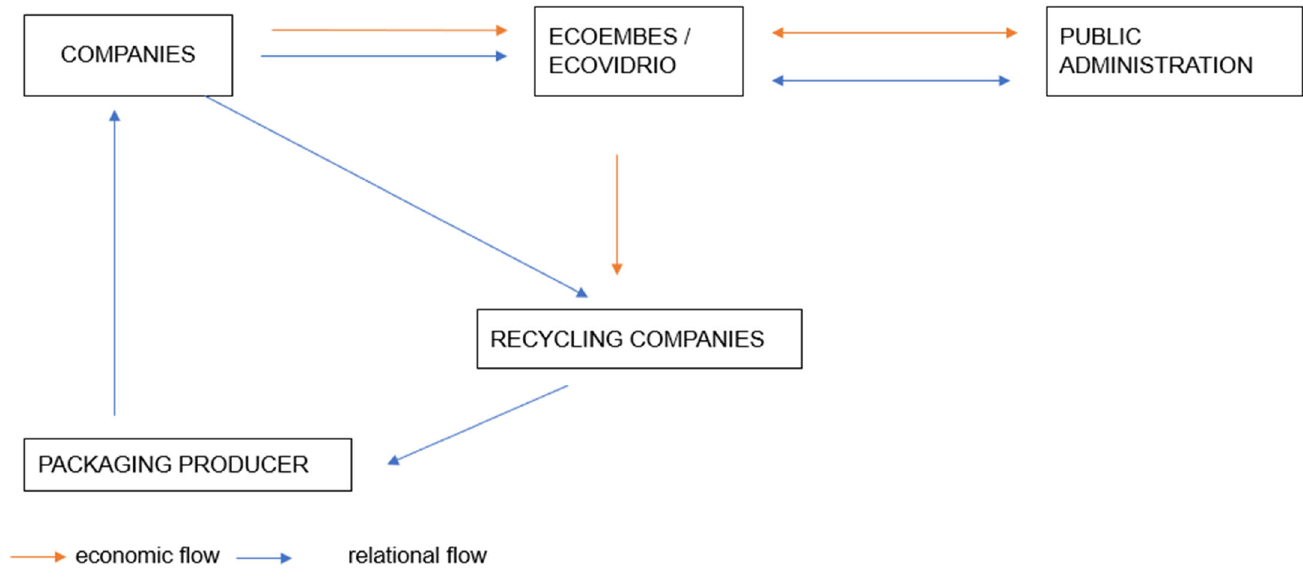
Figure 7. Spanish model. Source: own elaboration based on [38,39].